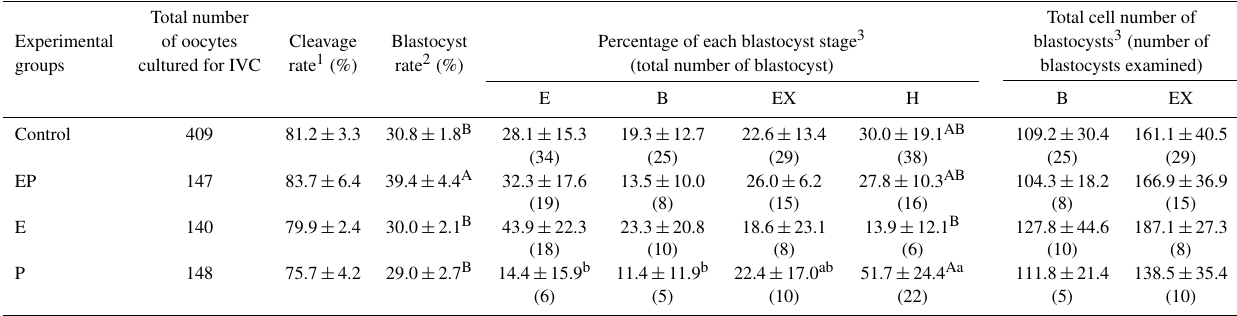
Table 2. The effect of three-step IVM culture imitating temporal changes of E 2 and P 4 concentrations in preovulatory follicles on in vitro maturational and developmental competence of bovine oocytes. Total number Total cell number of Experimental of oocytes Cleavage Blastocyst Percentage of each blastocyst stage 3 blastocysts 3 (number of groups cultured for